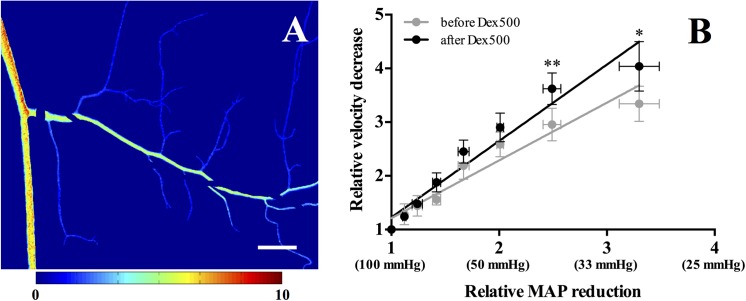
Relative velocity in the venular network.
A: Typical example of the relative velocity decrease map at 30 mmHg. B: Relative velocity decrease at each MAP with respect to the normal arterial pressure (MAP = 100 mmHg). The solid lines represent linear regression fits before (y = 1.075x + 0.136, R
2 = 0.58, significance of slope: P < 0.0001) and after (y = 1.422x − 0.196, R
2 = 0.70, significance of slope: P < 0.0001) dextran infusion, respectively. Scale bar = 500 μm.